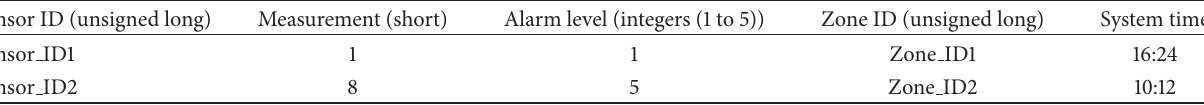
Table 3: Output table of the Alarm Generation Service.